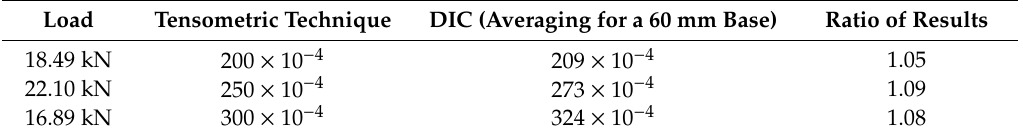
Table 3. Linear vertical strains (cross machine direction)—glass fibre geogrid; average values of strains from 5 samples [52]. Table 4. Linear vertical strains (machine direction)—polyester geogrid; average values of strains from 5 samples [52].